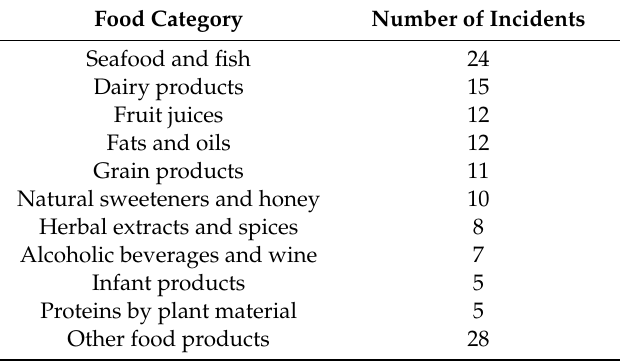
Table 4. Incidents of economically motivated adulteration in 11 food categories from 1980 to 2013. Food Category Number of Incidents Seafood and fish 24 Dairy products 15 Fruit juices 12 Fats and oils 12 Grain products 11 Natural sweeteners and honey 10 Herbal extracts and spices 8 Alcoholic beverages and wine 7 Infant products 5 Proteins by plant material 5 Other food products